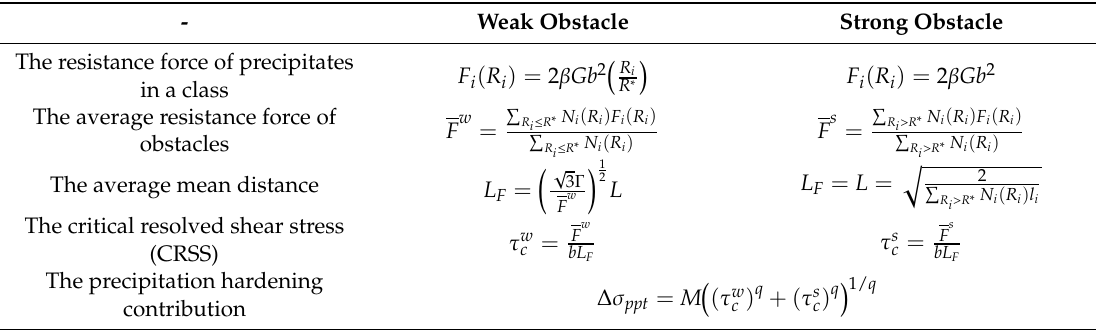
Table 1. The governing equations of precipitation hardening